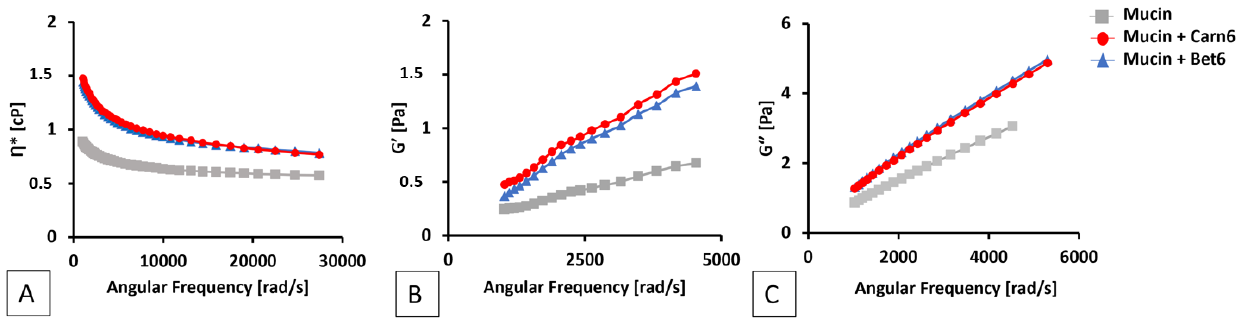
Table 2. Relative viscosity of mucin samples, either plain (mucin) or in the presence of Bet6 or Carn6 ionic liquids applied at 0.20 M (lower than CAC) or at 0.27 M (higher than CAC). Sample Relative Viscosity (cP) Mucin 0.75 ± 0.03 Mucin/Bet6 (0.20 M) 0.79 ± 0.01 Mucin/Bet6 (0.27 M) Mucin/Carn6 (0.27 M) 1.31 ± 0.26 The increase in complex viscosity was reflected in the increase in the moduli of G (cid:48) and G (cid:48)(cid:48) (Figure 5). At concentrations below the CAC, there was no increase in viscosity with respect to the mucin reference sample (data not shown).